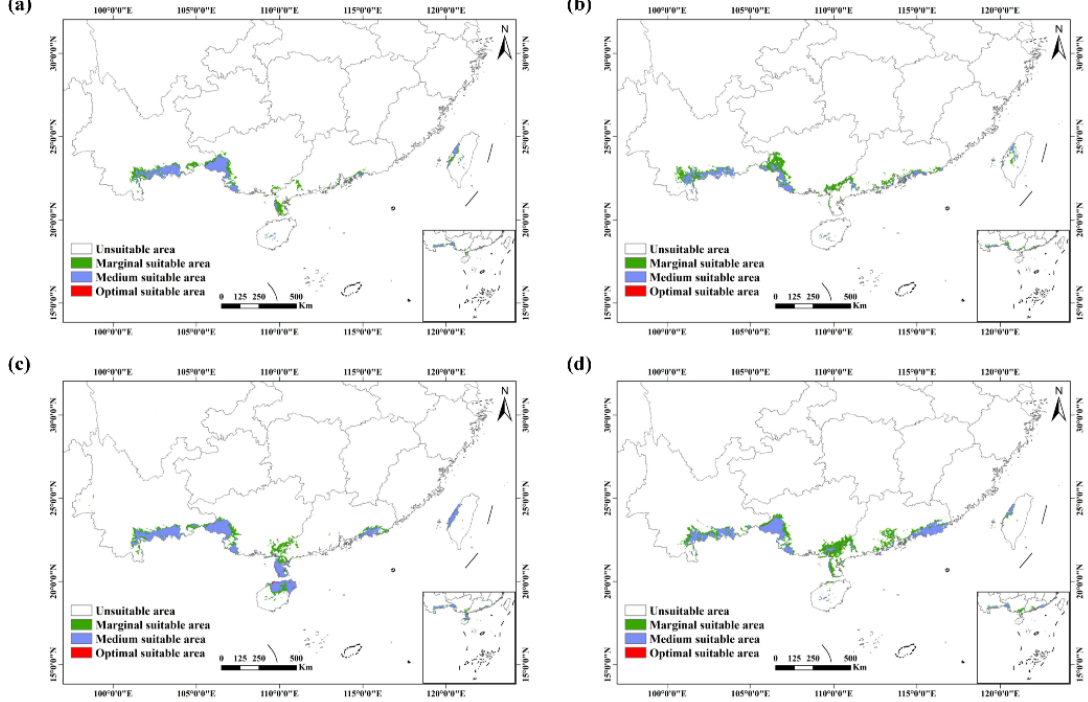
Figure 6. Projected potential distribution maps of H. tetratepala under future periods (2070s) in MIROC6 models: (a) SSP 2.6, (b) SSP 4.5, (c) SSP 7.0, and (d) SSP 8.5.